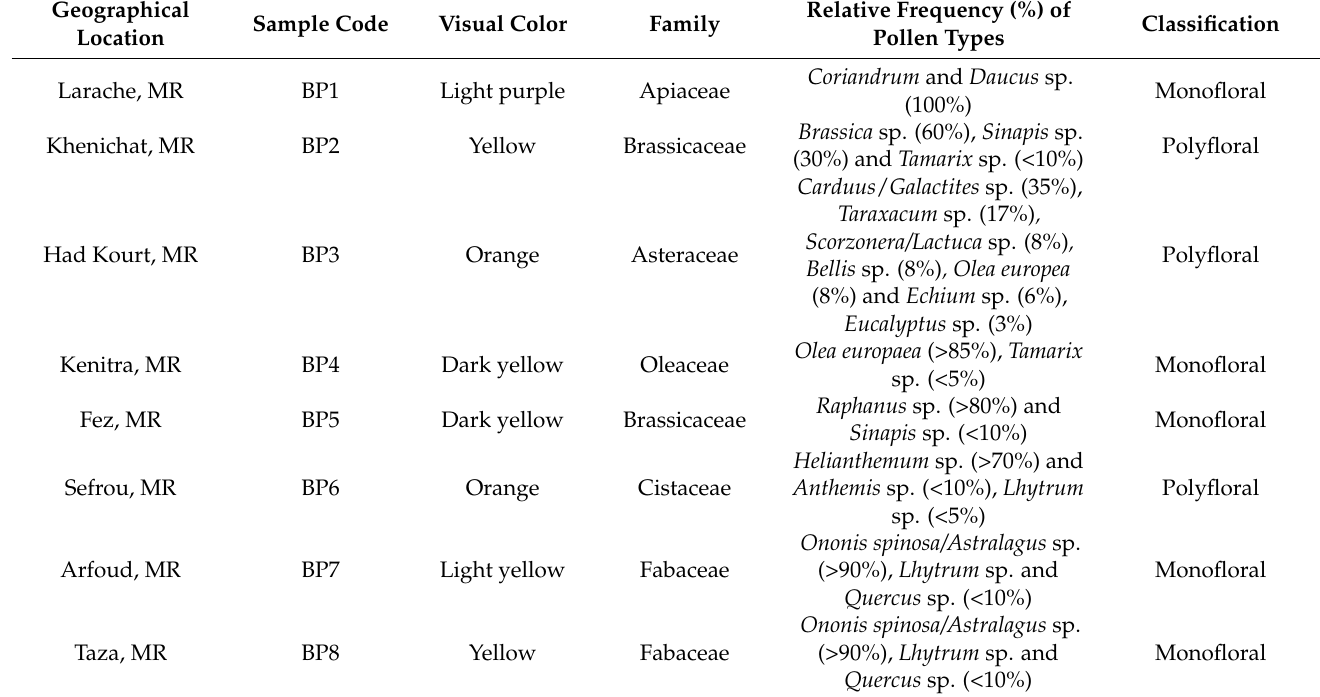
Table 1. Geographical location, codes, colors, and botanical origin of bee pollen